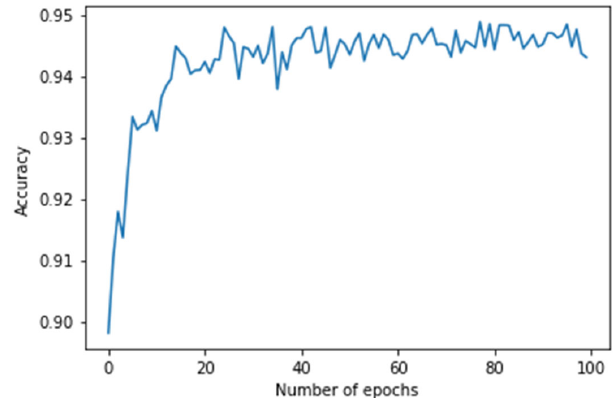
Figure 7. Graph showing the plot of the loss function with several epochs in the x -axis and its corresponding losses in the y -axis.